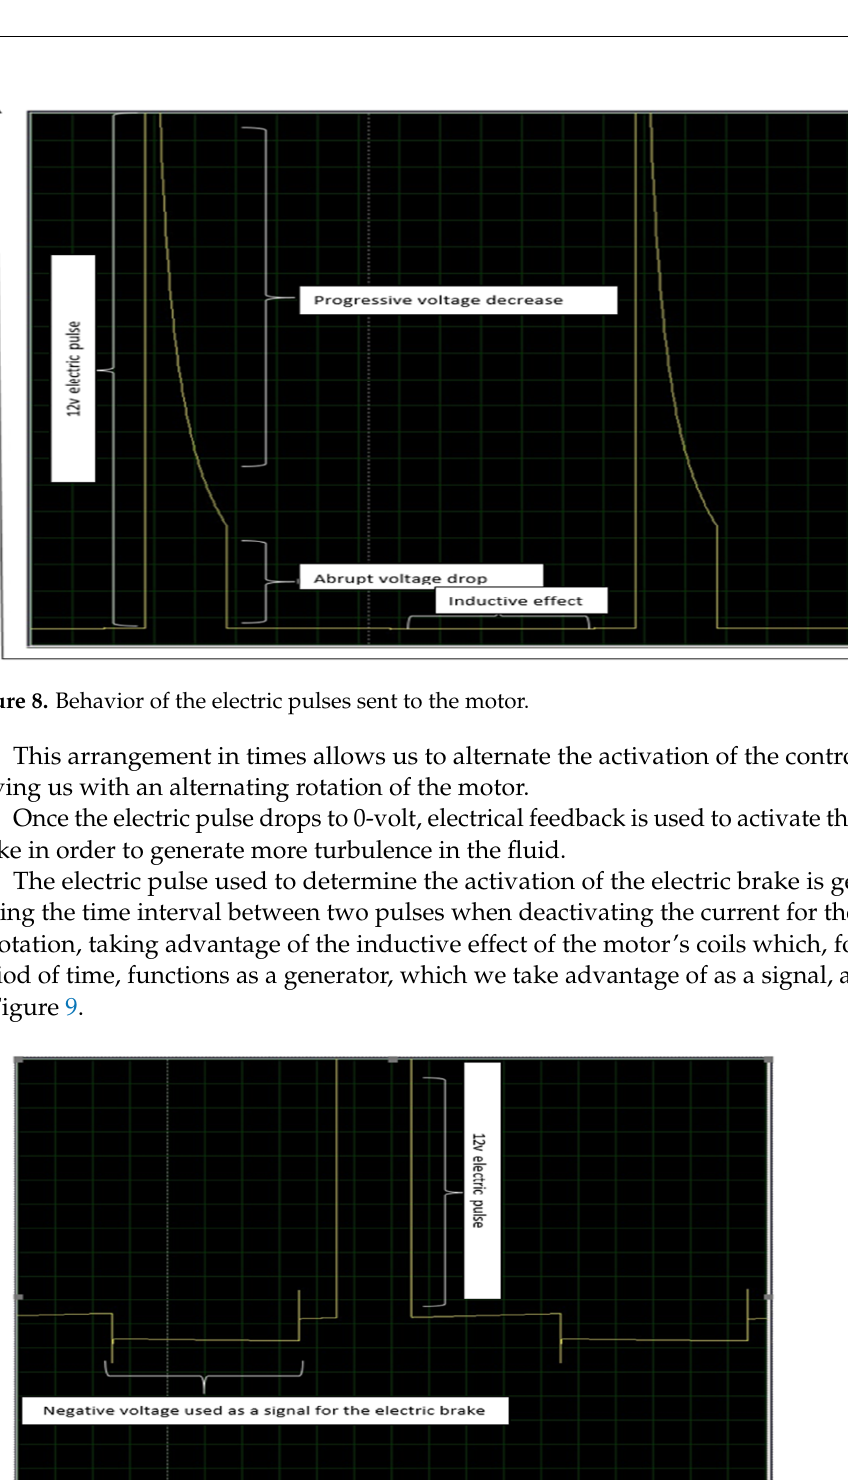
Figure 7. Analog outputs phased in time to control the direction of rotation of the motor. This arrangement in times allows us to alternate the activation of the control stages, leaving us with an alternating rotation of the motor.